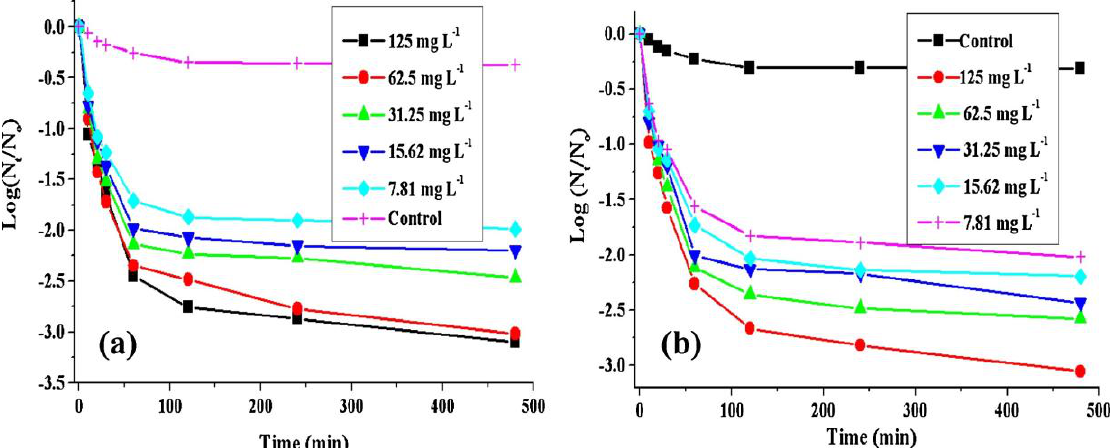
Figure 11. The inactivation curve of Fe 3 O 4 @PTA@Ag-3 toward E. coli ( a ) and S. aureus ( b ) (adapted with permission from reference [79]).